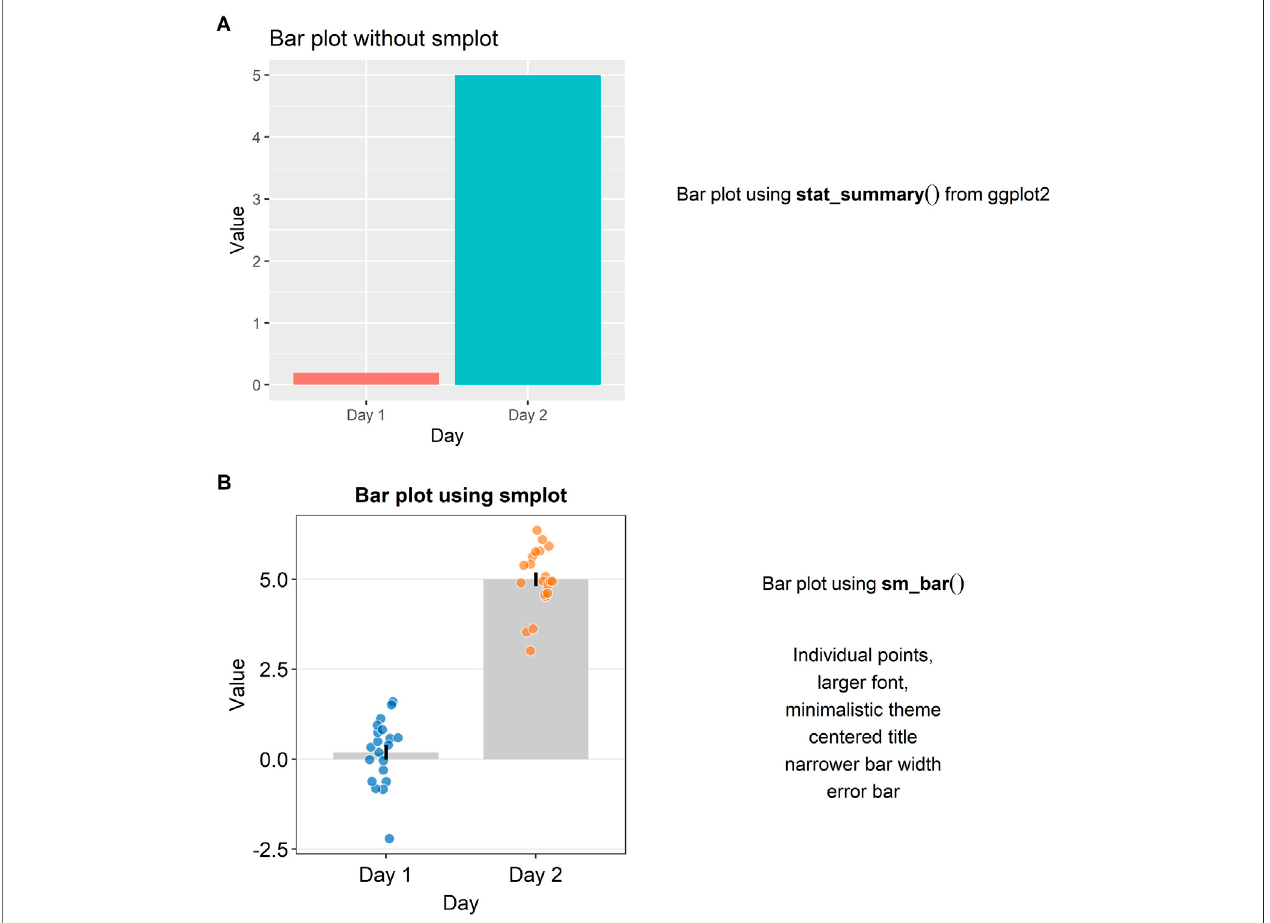
FIGURE 2 | Bar plots with and without smplot . (A) A bar plot drawn with “ stat_summary() ” , which is a function of ggplot2. (B) A bar plot drawn with “ sm_bar() ” , whichisafunctionofsmplot. Thisfunctionautomaticallyprovidesseveralfeatures,such asindividualdatapoints, largerfont,minimalistictheme,centeredtitle,narrower bar width and error bars, such as standard error, standard deviation or 95% con fi dence